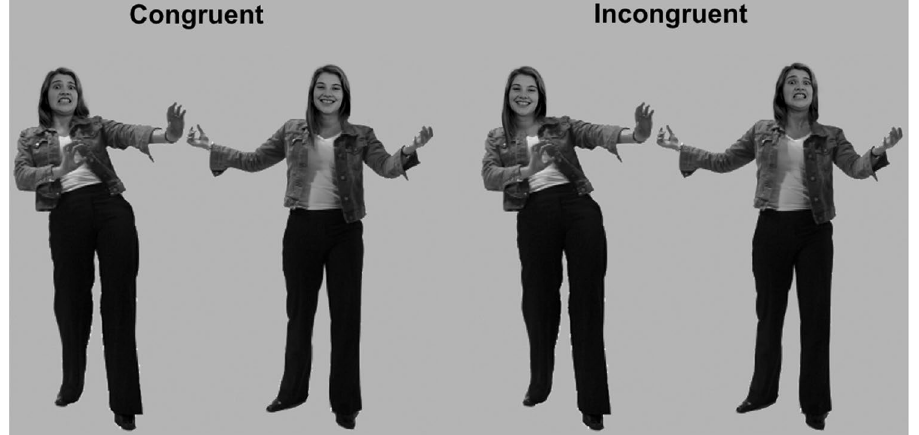
Figure 2. Face-body compound test to assess emotion recognition. Example of the emotionally congruent and incongruent face-body compounds of fearful and happy emotional expressions.